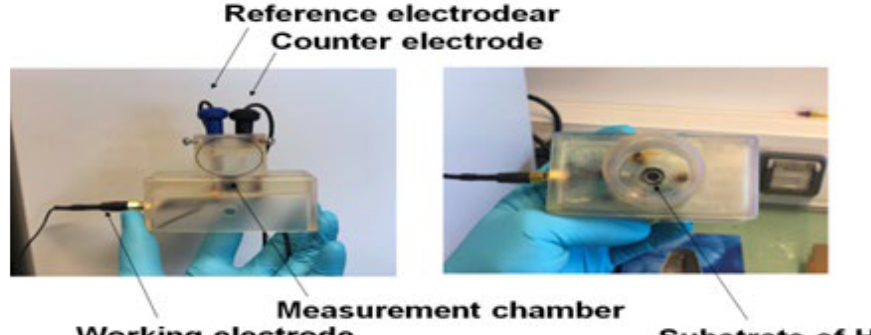
Figure 5. Experimental setup.